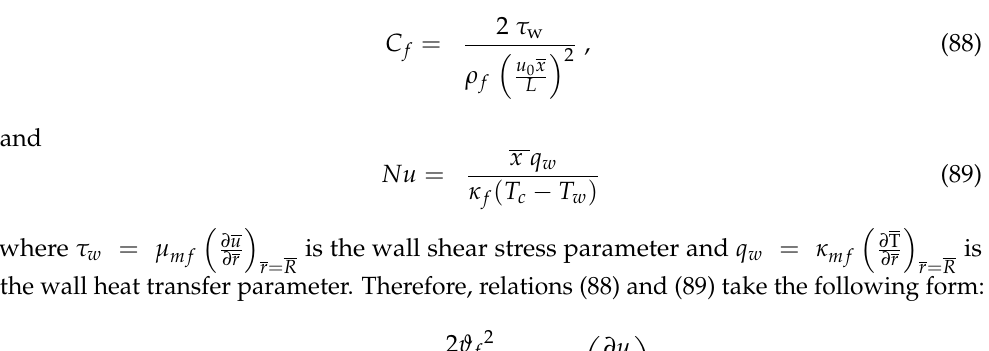
Figure 16. (Case a): Variations of  for 003 . 0 , 002 . 0 , 001 . 0 = E c against of heat transfer Nu (local Nusselt number) which are defined by